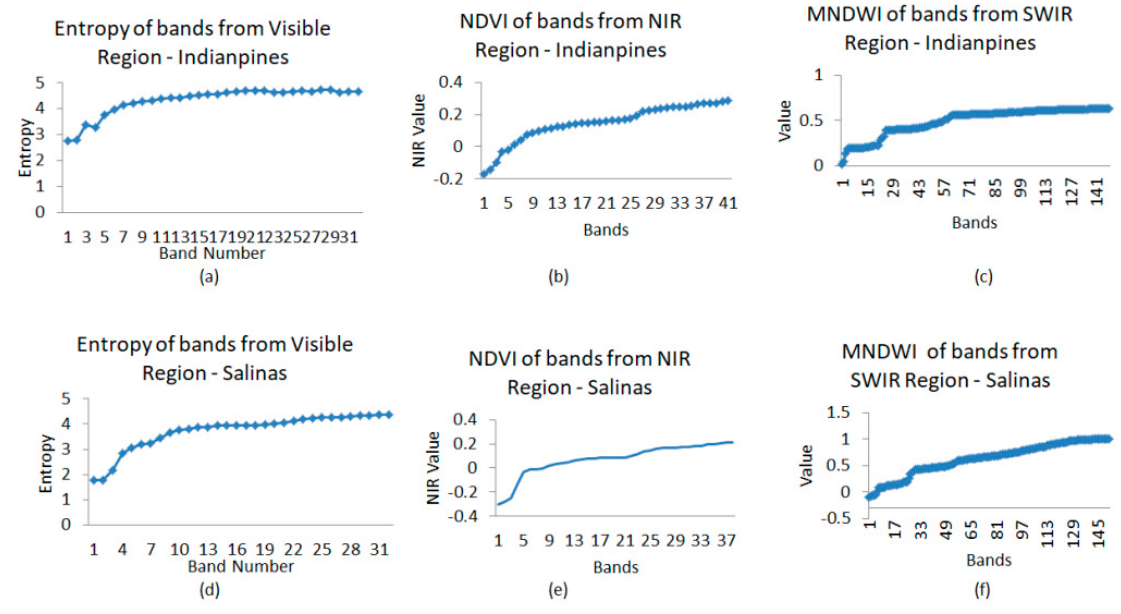
Figure 7. Row-1: Indian Pines data ( a ) Entropy of visible region bands ( b ) NDVI of NIR region bands ( c ) MNDWI of SWIR region bands. Row-2: Salinas’s data ( d ) Entropy of visible region bands ( e ) NDVI of NIR region bands ( f ) MNDWI of SWIR region bands (Bands on x -axis for ( b , c , e , f ) are the chosen bands from the respective region).